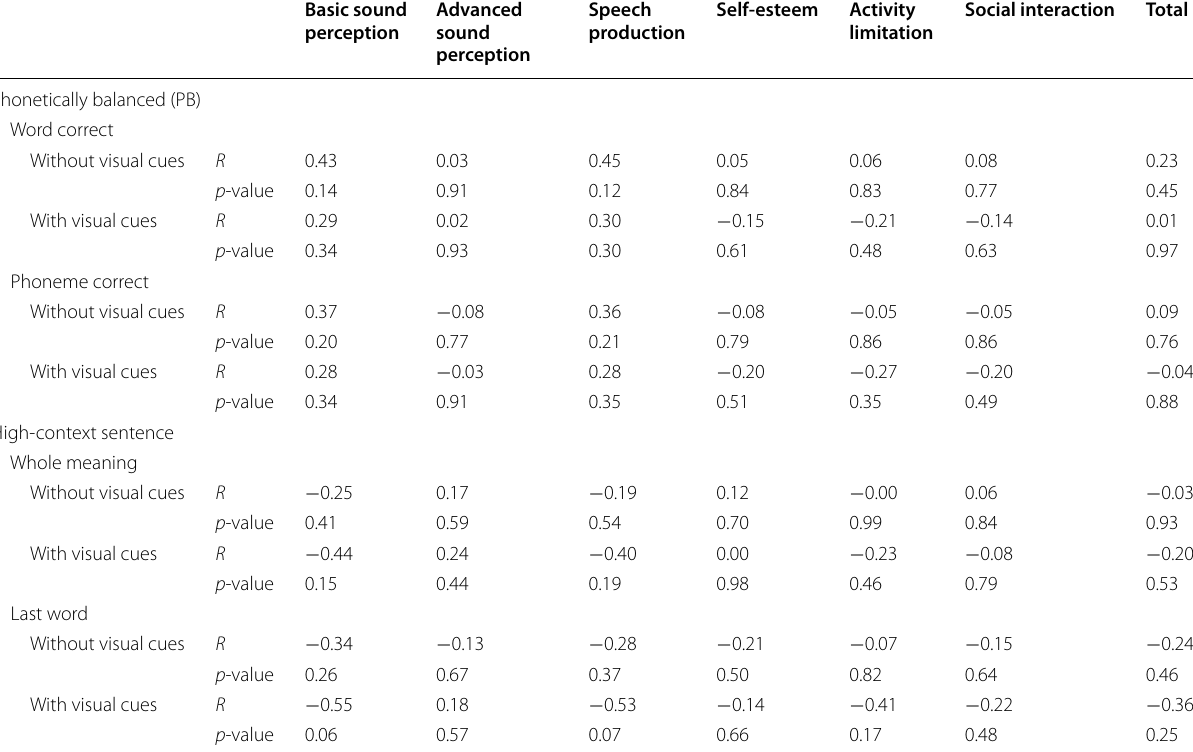
Table 5 Correlation between NCIQ-Arabic version subdomains and speech perception tests in adults, showing no statistically significant